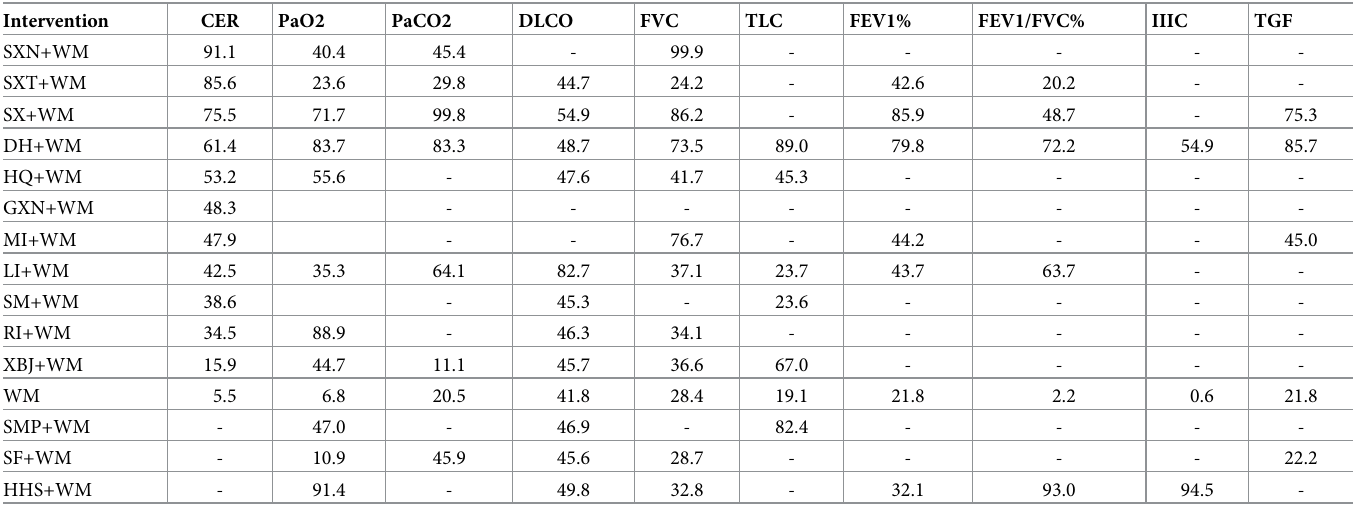
Table 2. Surface under the cumulative ranking curve (SUCRA) results of the outcomes. Intervention